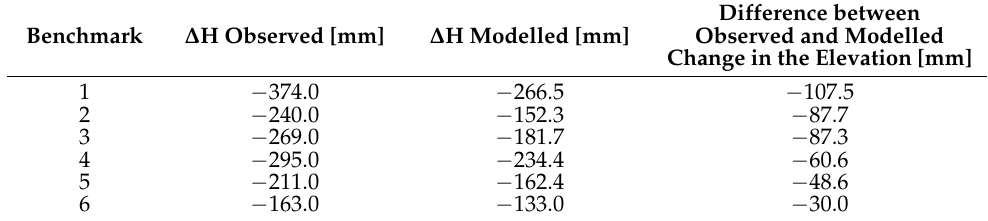
Table 2. Land subsidence in imposing direct and indirect impacts of hard coal exploitation in the Bogdanka mine estimated based on changes in the elevation of the benchmarks observed and modelled in